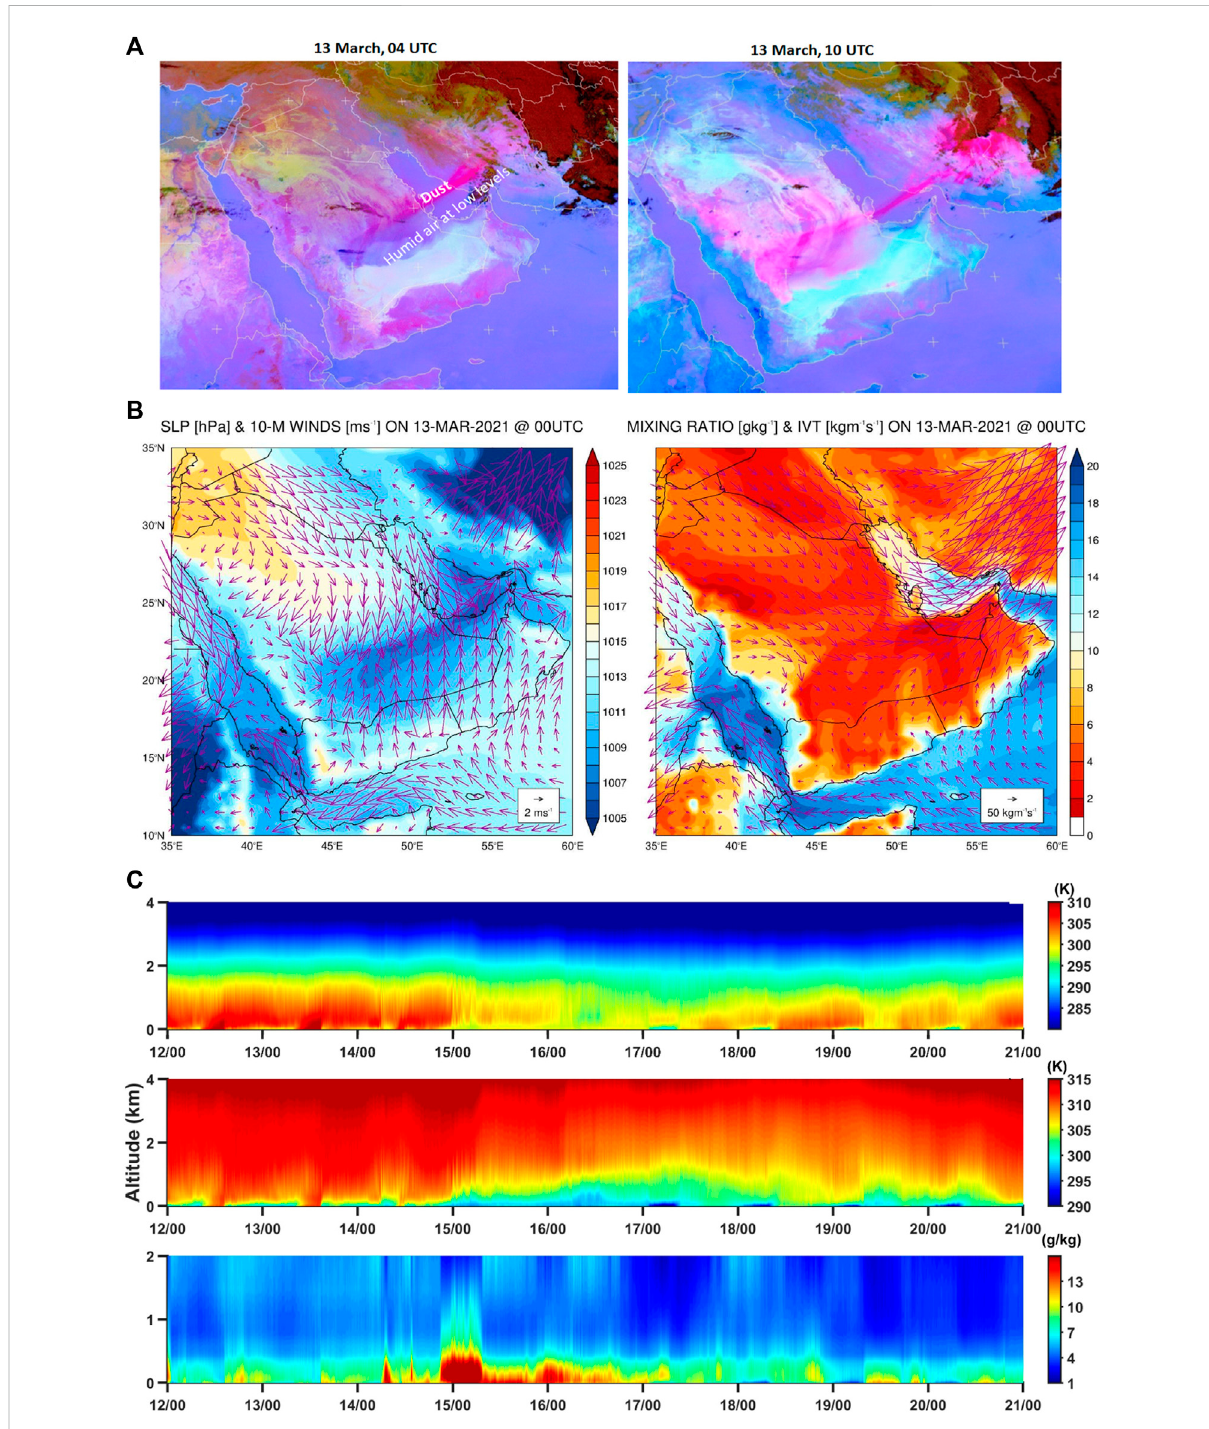
FIGURE 12 (A) False colour Red-Green-Blue (RGB) images from SEVIRI (Banks et al., 2019) on 13 March 2021 at 04 and 10 UTC. In both panels, thick high- level clouds are shaded in orange or brown while thin high-level clouds are shaded in black; dust is given in magenta or pink, and sandy regions are highlighted in white; dry land is shaded in pale blue during daytime and pale green at night. (B) (left) sea-level pressure (SLP; shading; hPa) and 10-m wind (vectors; m s − 1 ) and (right) 2-m water vapour mixing ratio (shading; g kg − 1 ) and integrated vapour transport (IVT; vectors; kg m − 1 s − 1 ) at 00 UTC on 13 March. (C) From top to bottom: Vertical pro fi les of air temperature (K), potential temperature (K) and speci fi c humidity (g kg − 1 ) below 4 km in altitudes for the period 12 to 21 March 2021 derived from the MWR